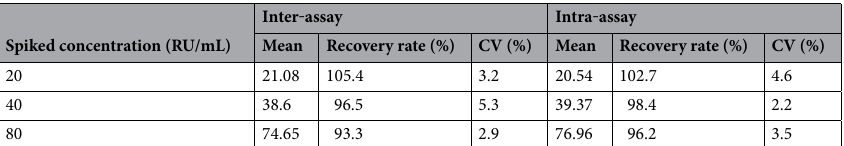
Spiked concentration